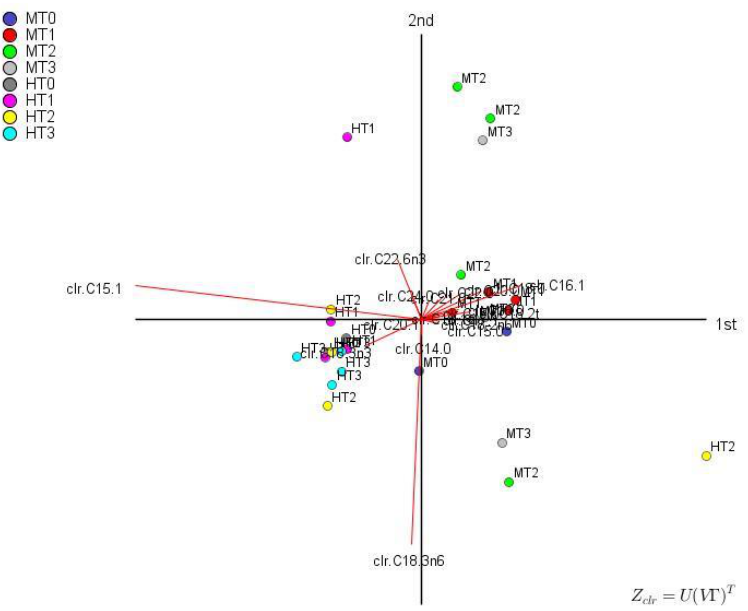
Figure 2. CoDa covariance biplot, appropriate to study the relationship among variables. PC1 ac- counted for 45.70% variance and PC2 for 26.07% (together, 71.77%). M, Manzanilla; H,